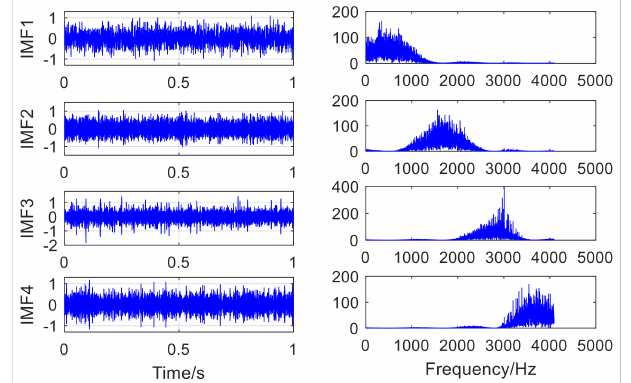
Figure 4. The result of decomposing the mixed signal by AVMD. Table 2. Information entropy of each IMF component.